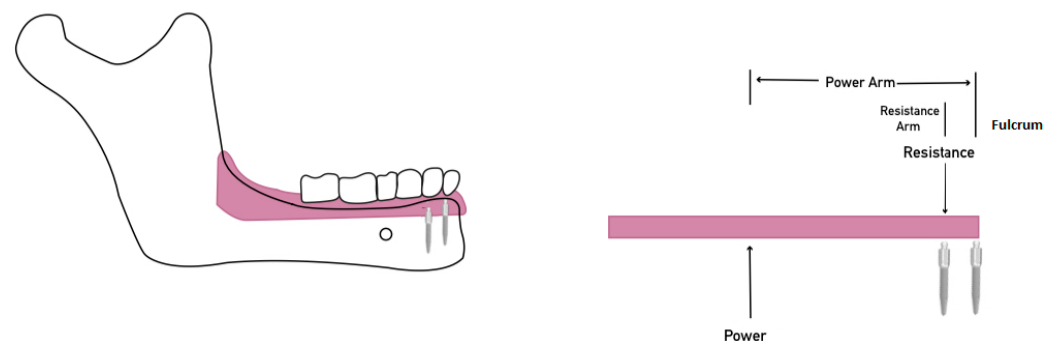
Figure 5. Class II lever system with anterior MDI act as a fulcrum, posterior MDI act as a resistance and the power is the posterior dislodging force. Due to the close placement between the anterior and posterior MDIs, the short resistance arm reduces the mechanical advantage.